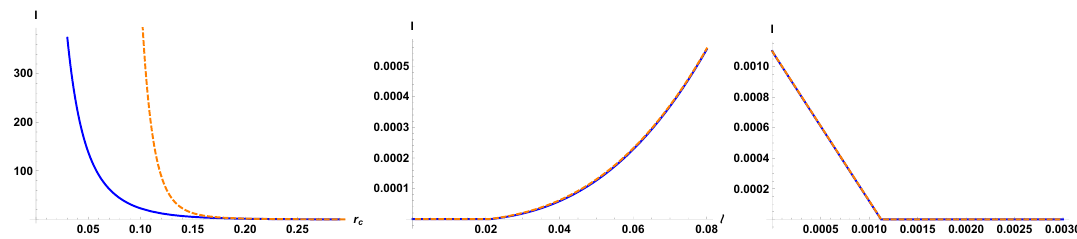
Figure 17 . HMI for very small entangling regions, i.e. ‘ (cid:28) r c : Left ) as a function of r c for h = 10 − 2 , ‘ = 10 − 1 and d e = 3 . The blue curves are the numerical results based on eq. (3.17), and the orange dashed curves are based on eq. (4.17) which are valid for very small entangling regions. Middle ) as a function of ‘ for h = 10 − 5 , r c = 1 and d e = 3 . Right ) as a function of h for ‘ = 0 . 1 , r c = 1 and d e = 3